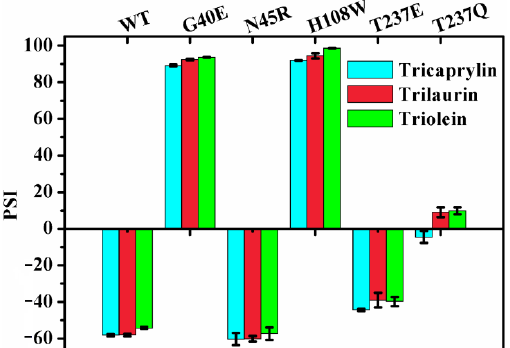
Figure 5. The effect of chain length on regiospecificity of MAS1 and its